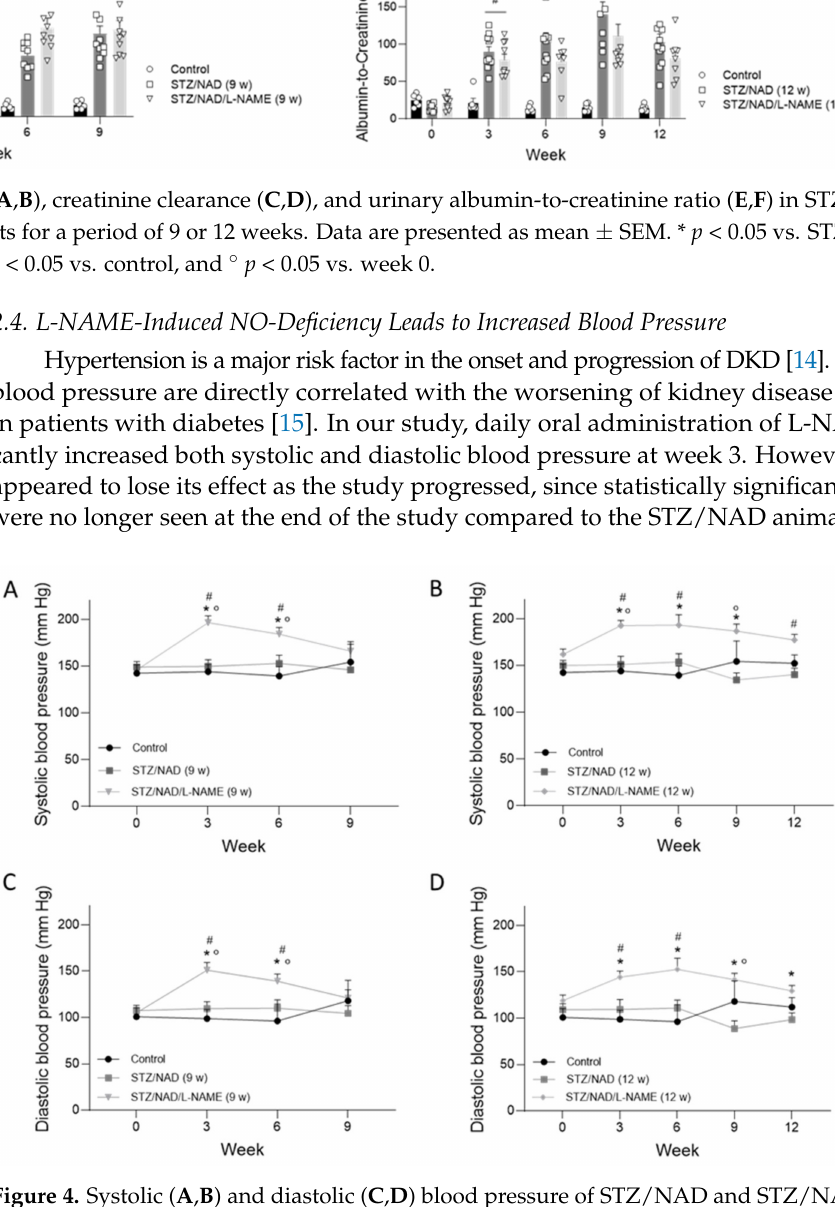
Figure 4. Systolic ( A , B ) and diastolic ( C , D ) blood pressure of STZ/NAD and STZ/NAD/L-NAME diabetic rats for a period of 9 ( A , C ) or 12 weeks ( B , D ) and non-diabetic control rats. Data are presented as mean ± SEM. * p < 0.05 vs. STZ/NAD, # p < 0.05 vs. control, and ◦ p < 0.05 vs. week